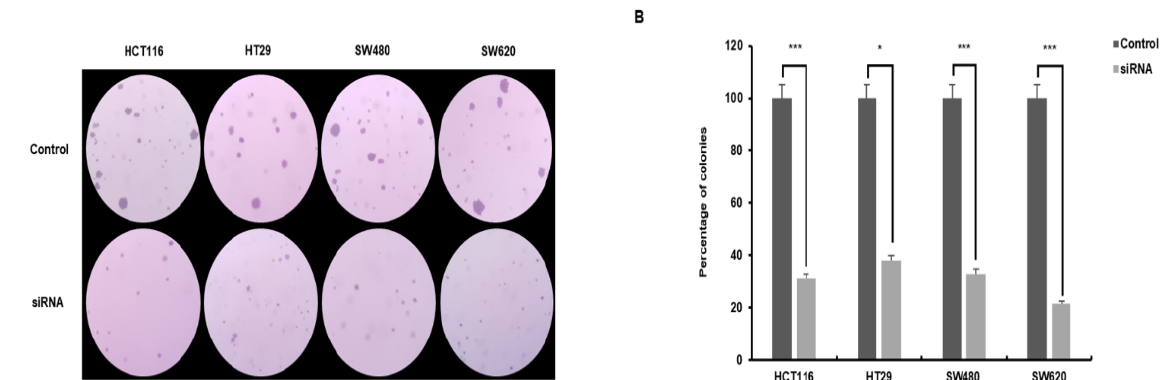
Table 2. Cox regression analysis of the clinicopathological factors in CRC.